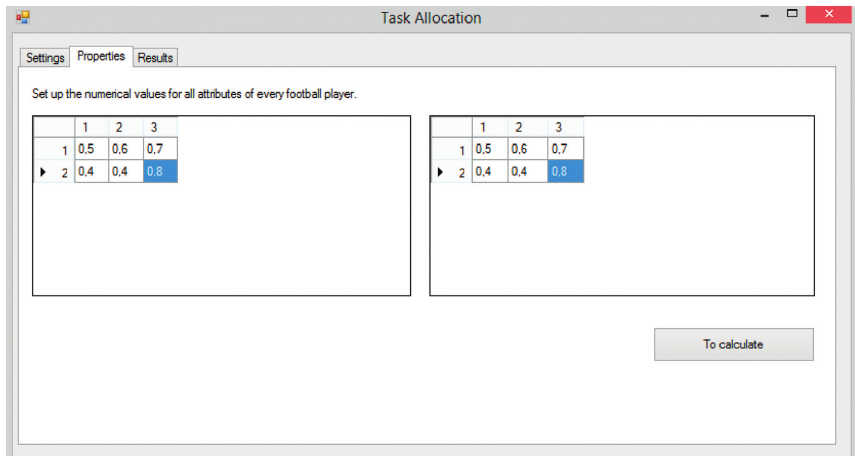
Figure 11: Entering the values of the mobile objects’ properties of the group of red and blue in the third experiment.